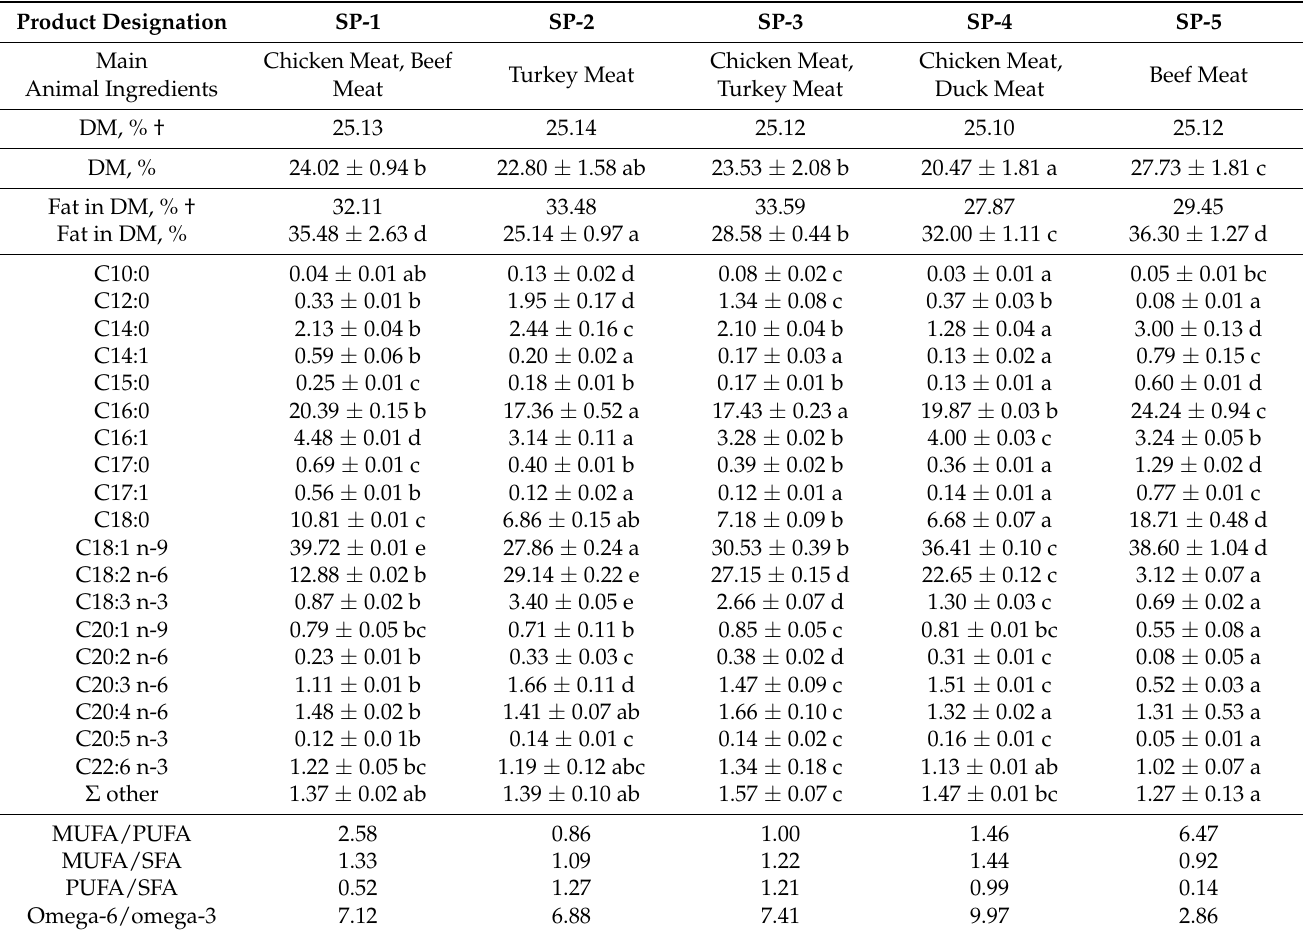
Table 1. Main animal ingredients: dry matter (DM), fat content and fatty acid composition (%) in fats extracted from tested self-prepared (SP) cat